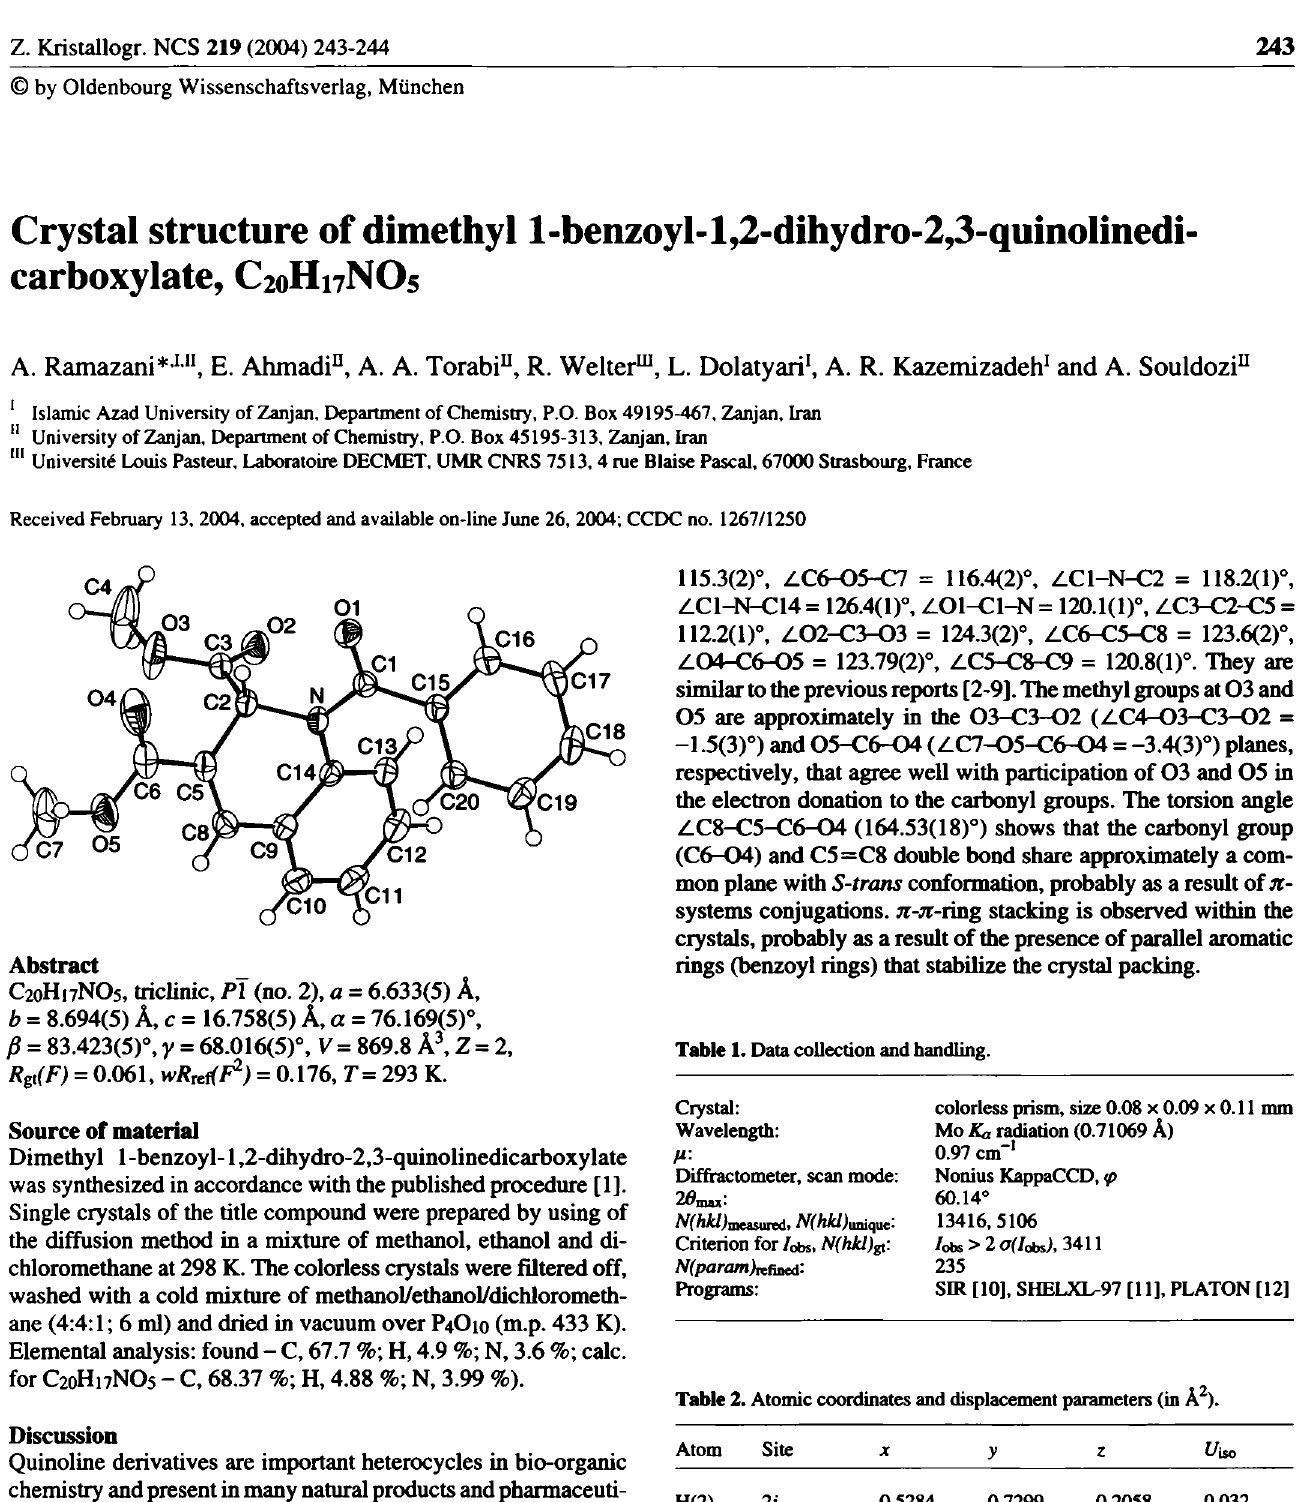
Table 2. Atomic coordinates and displacement parameters (in Â 2